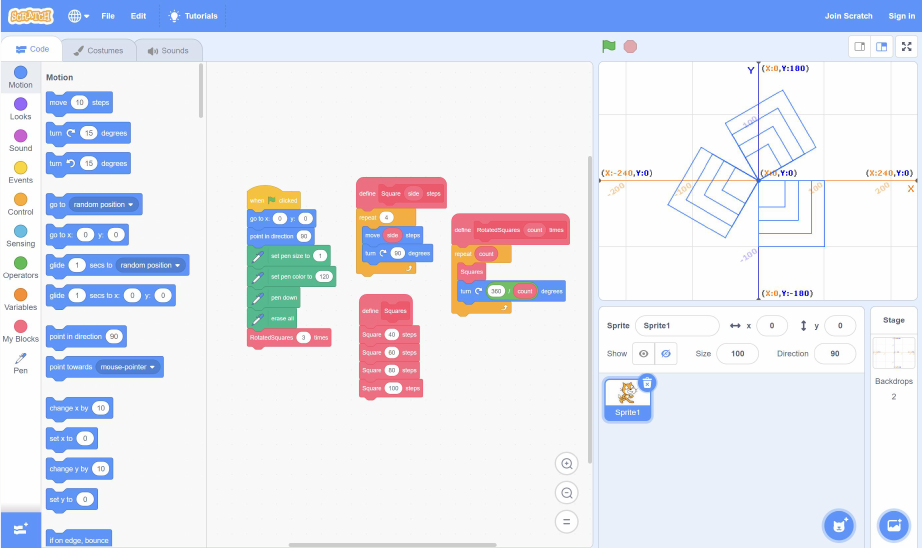
Figure 3. The effects of the work of students in the experimental class.